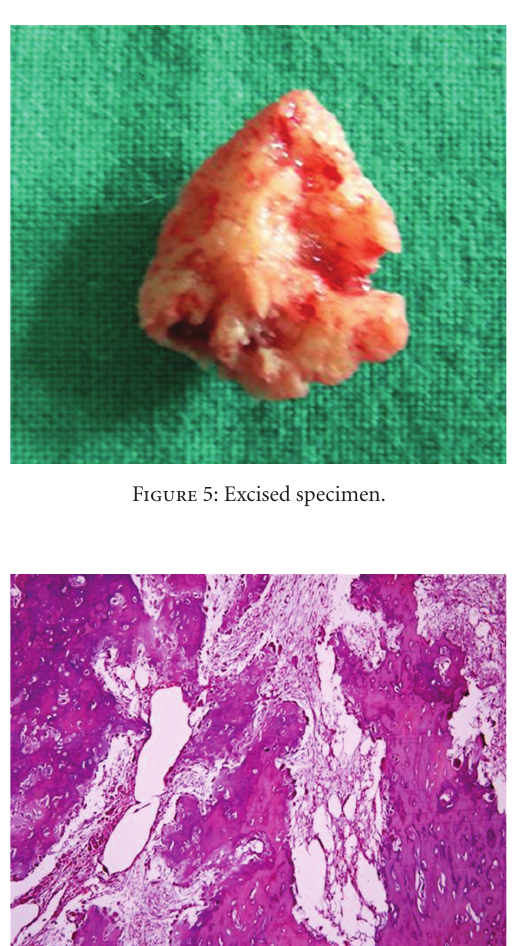
Figure 6: Histopathological picture of the